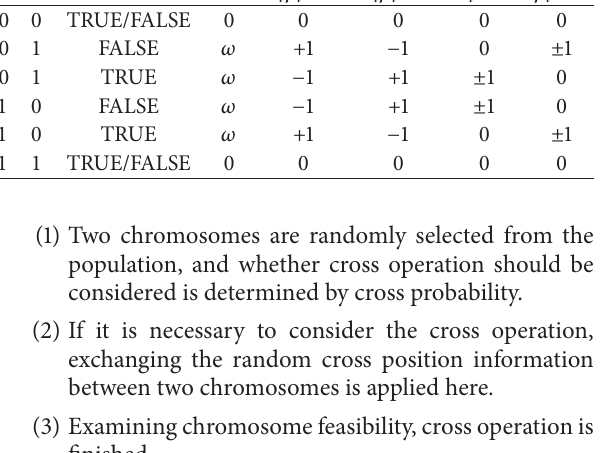
Table 1: The adjustment strategy of the quantum rotating angle. 𝑥 𝑏 𝑖